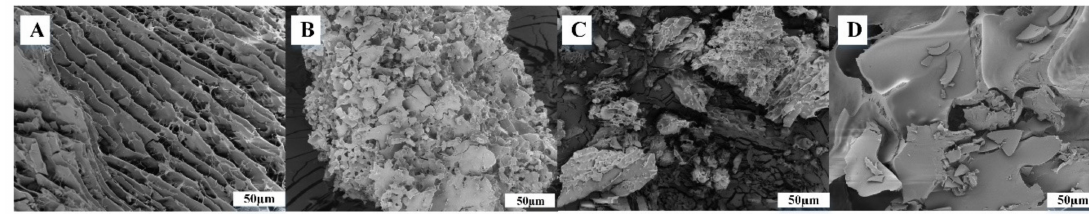
Figure 6. ( D )—PRF/VANKA.